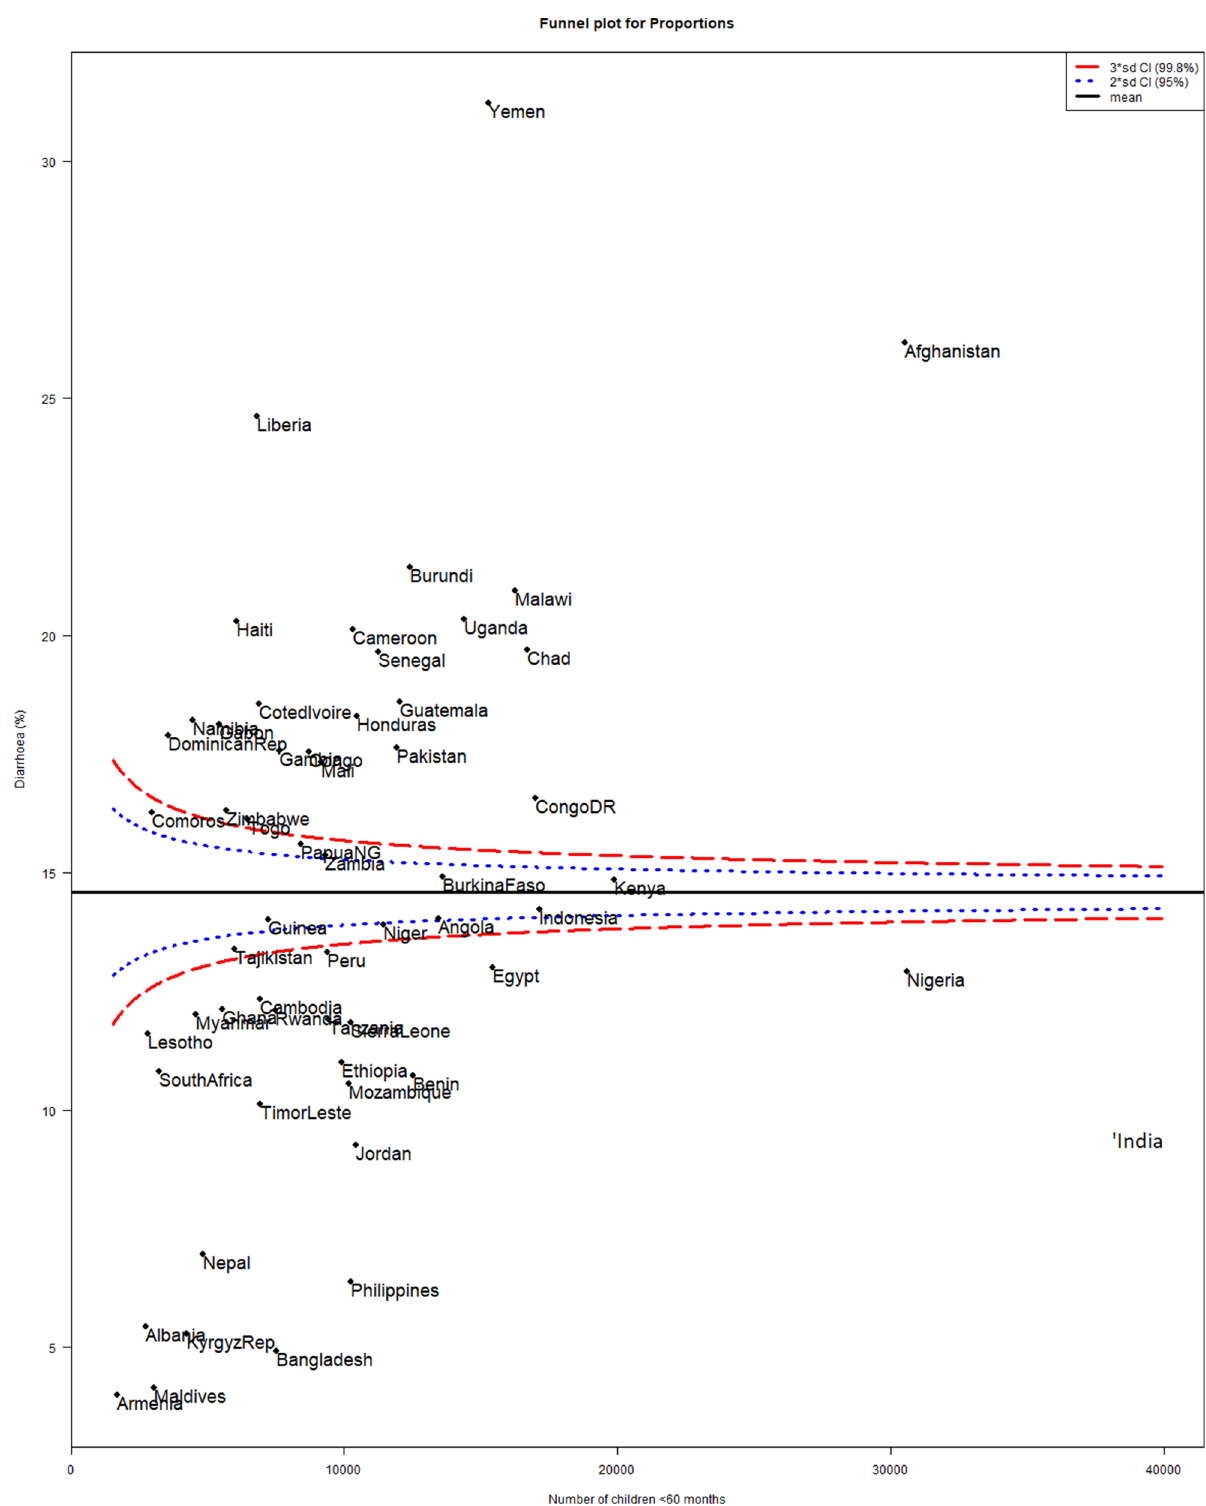
Figure 3. Funnel plot showing common- and special-cause variations in the prevalence of diarrhoea in LMIC (DHS